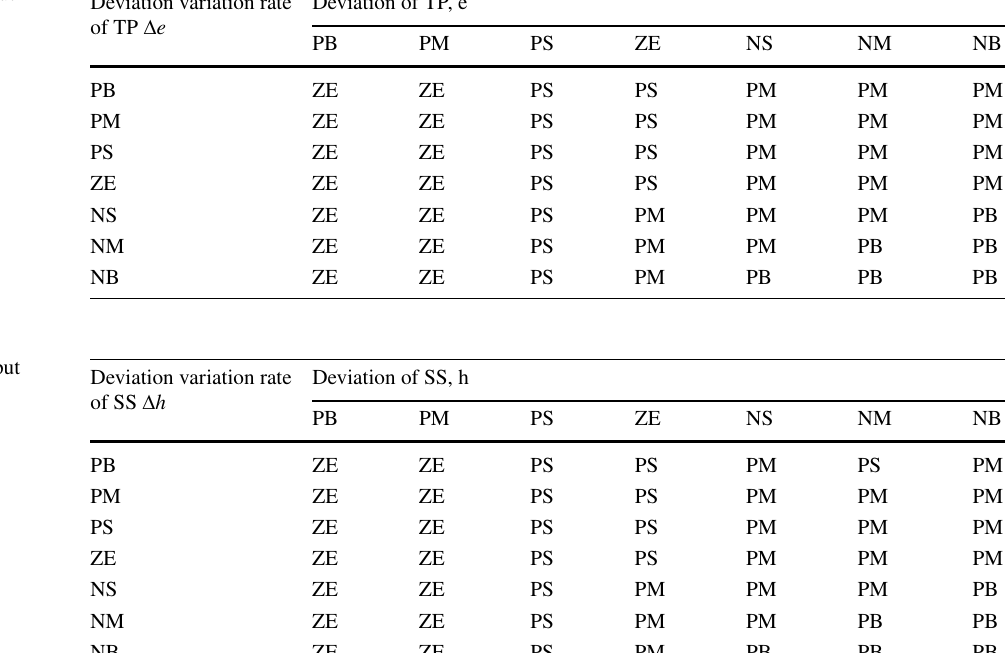
Table 1 PAC inverter output control rules